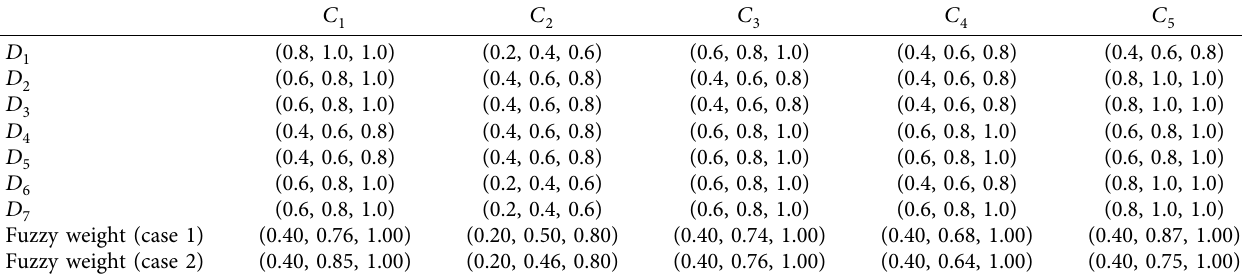
Table 1: The fuzzy weight of criteria from seven